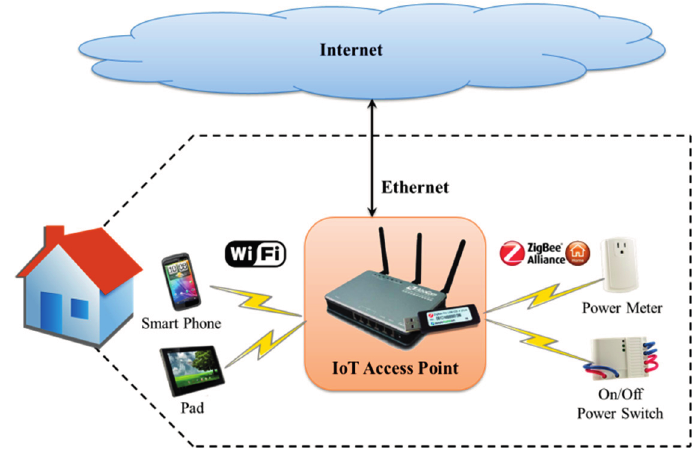
Figure 1. An Internet of Things (IoT) application: Smart Life